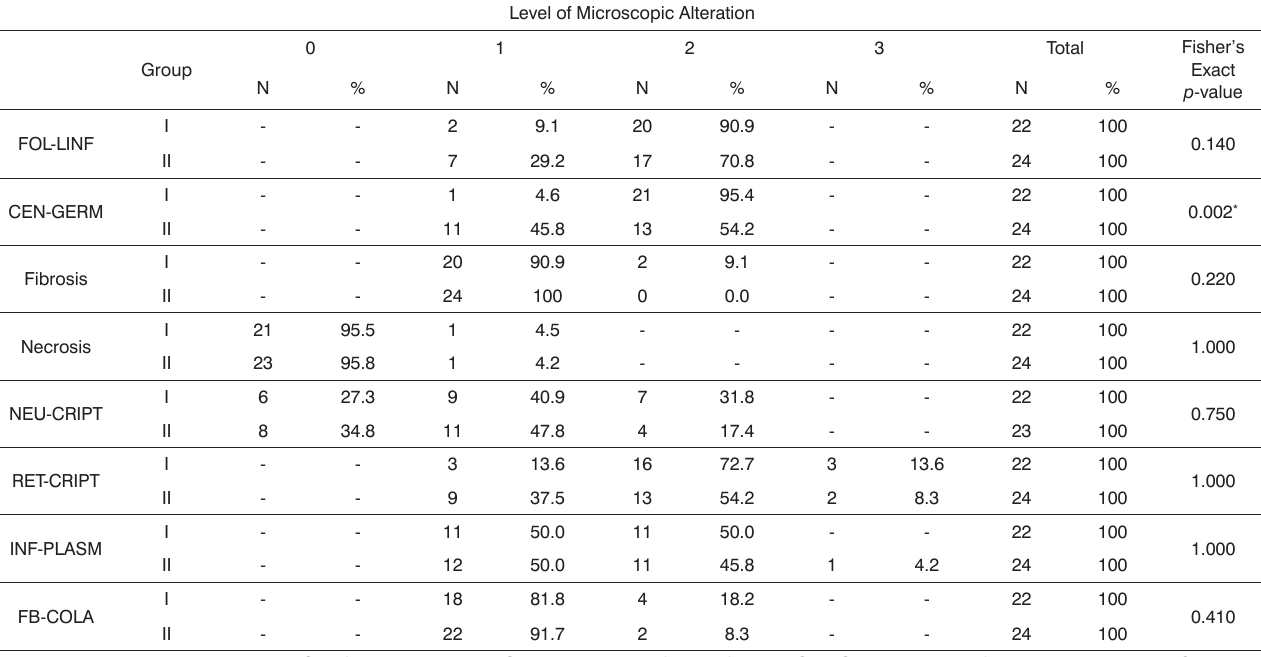
Table 2. Distribution of patients by the categorical variables: lymph follicles and germinal centers; fibrosis; necrosis; neutrophil permeation around the tonsil crypt epithelium and collagen fibrosis in the Hypertrophy Group (I) and Repetition Tonsillitis (II), and the level of these changes - from 2011 to